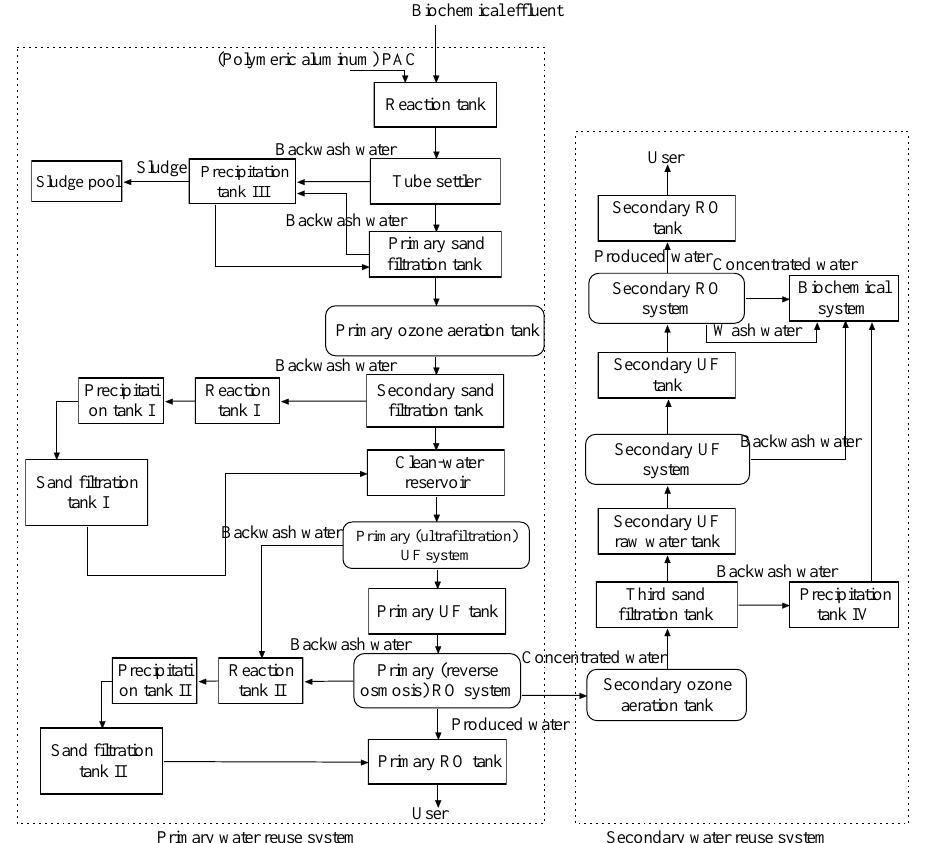
Figure 1. Schematics of the water reuse treatment processes.